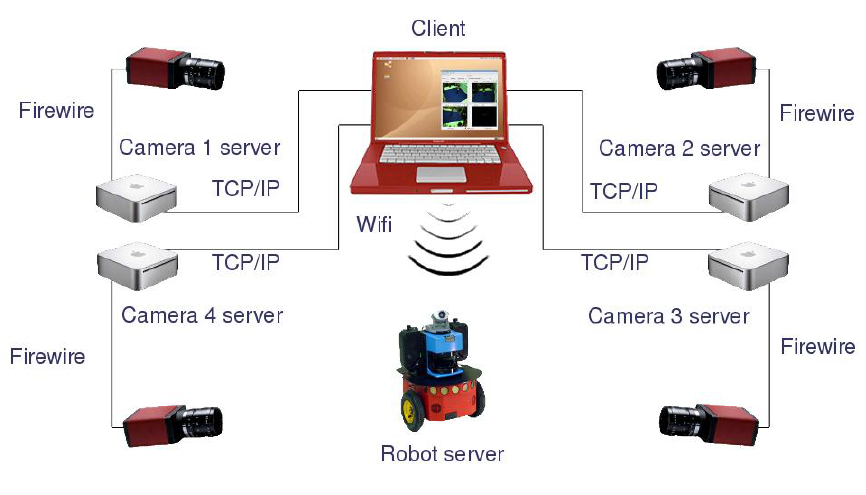
Figure 1. General diagram of the hardware/software architecture in the ISPACE-UAH.